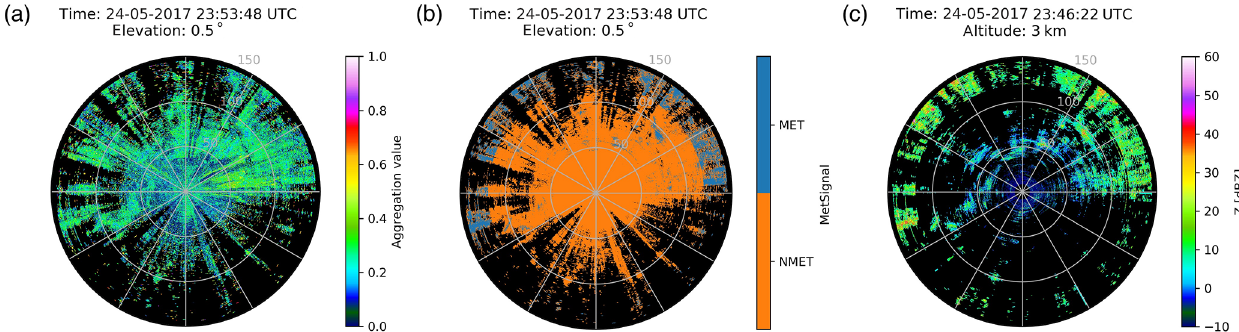
Figure 11. (a) A MET (MetSignal); (b) MetSignal; and (c) the CAPPI of Z at the altitude of 3km. (a, b) From NUIST-CDP at 23:53UTC on 24 May 2017 from an elevation of 0.5 ◦ , while (c) is at 23:46UTC on 24 May 2017 (the previous volume scan of a, b